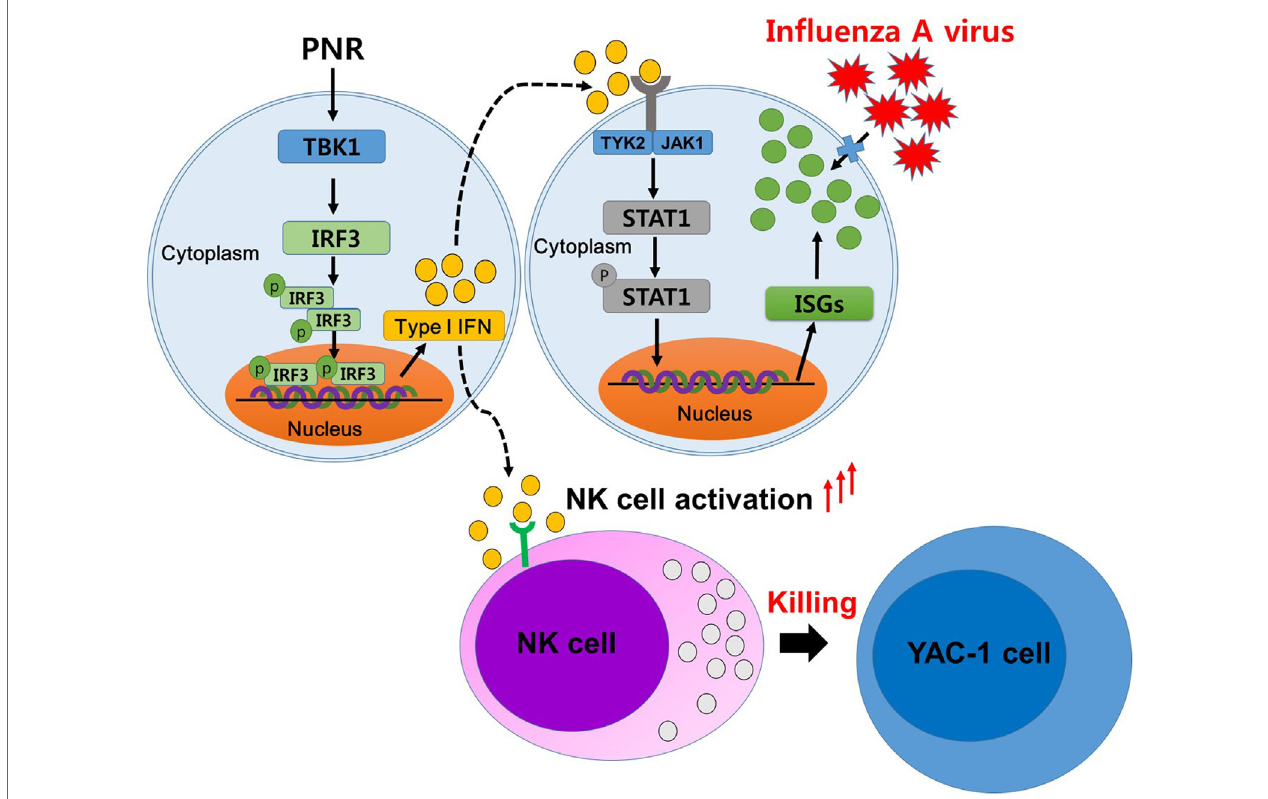
FigUre 10 | A schematic of the mechanism of Panax notoginseng root (PNR) in its enhancing of antiviral interferon-mediated immune responses and natural killer (NK) cell activity. PNR stimulates an antiviral state in murine macrophage cells by modulating the interferon (IFN) signaling pathway. PNR leads to the activation of IRF3 through TANK-binding kinase 1 (TBK1) and the production of type-I IFN. This secreted IFN can induce the inhibition of influenza A virus infection by stimulating the expression of stimulated target genes through the activation of signal transducer and activator of transcription 1, and these effects may be attributable to the ability of PNR to induce NK cell